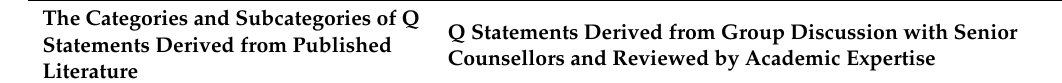
Table 1. List of the Q